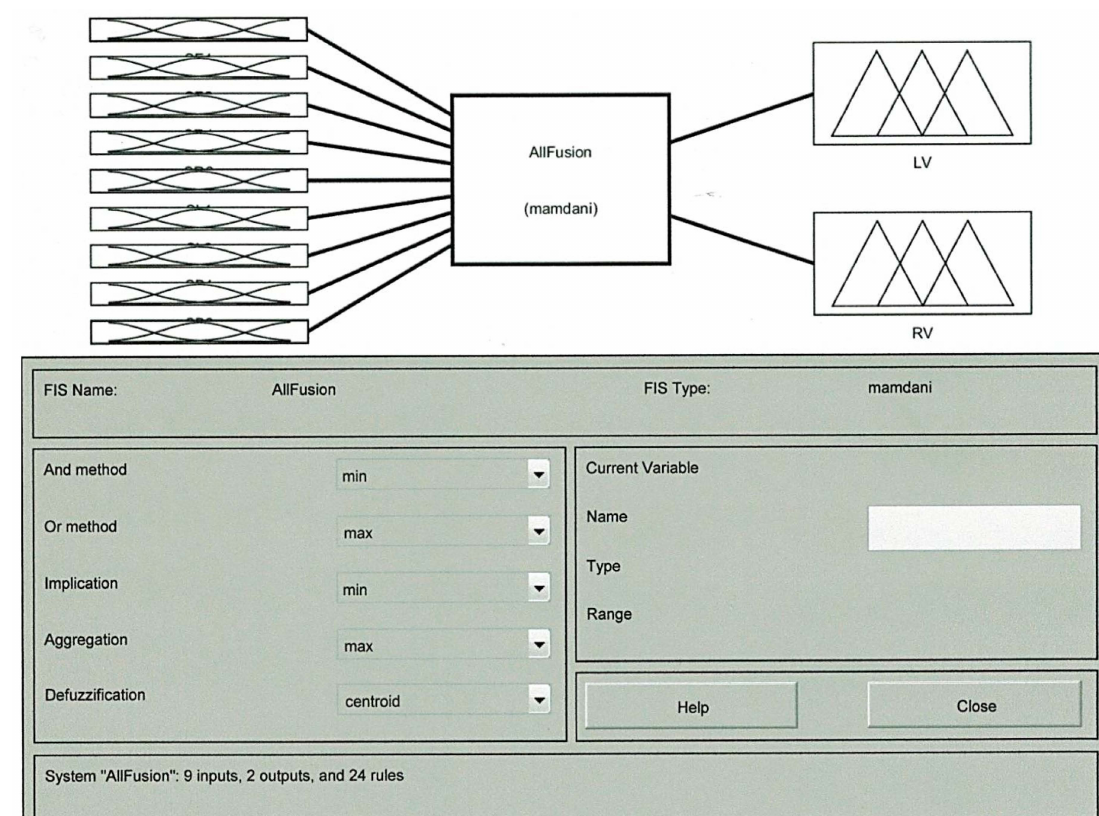
Figure 3. Fuzzy Inference System (FIS) with inputs and